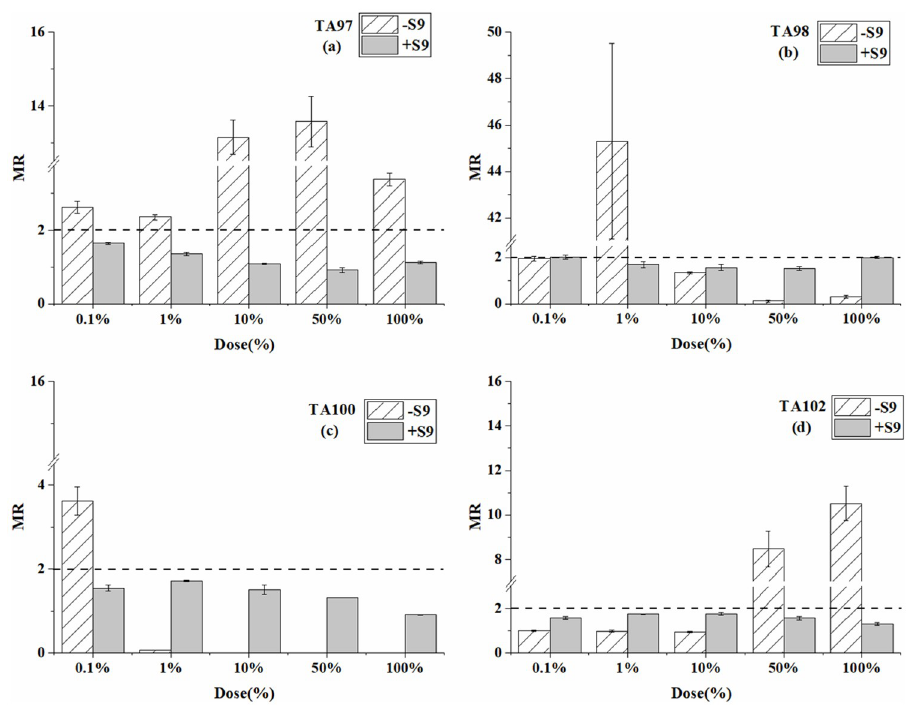
Fig 5. Mutagenesis of mixtures of BP-6, BP-8, and 4-MBC to four strains in the presence and absence of S9 liver extract; (a) TA97 strain; (b) TA98 strain; (c) TA100 strain; (d) TA102 strain. The mutation ratio (MR) is the average ratio ( ± SE) from three parallel